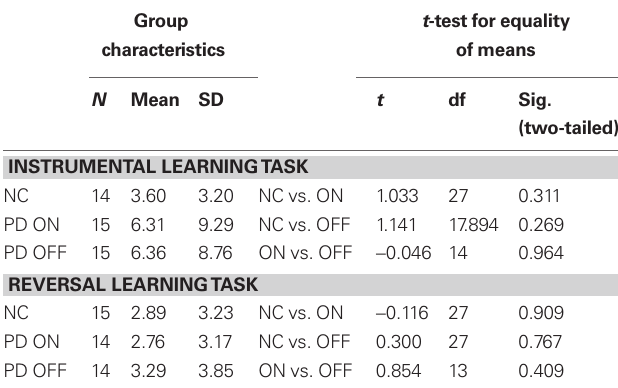
Table 6 | Mean percentage of missed trials across both reward-based learning tasks.